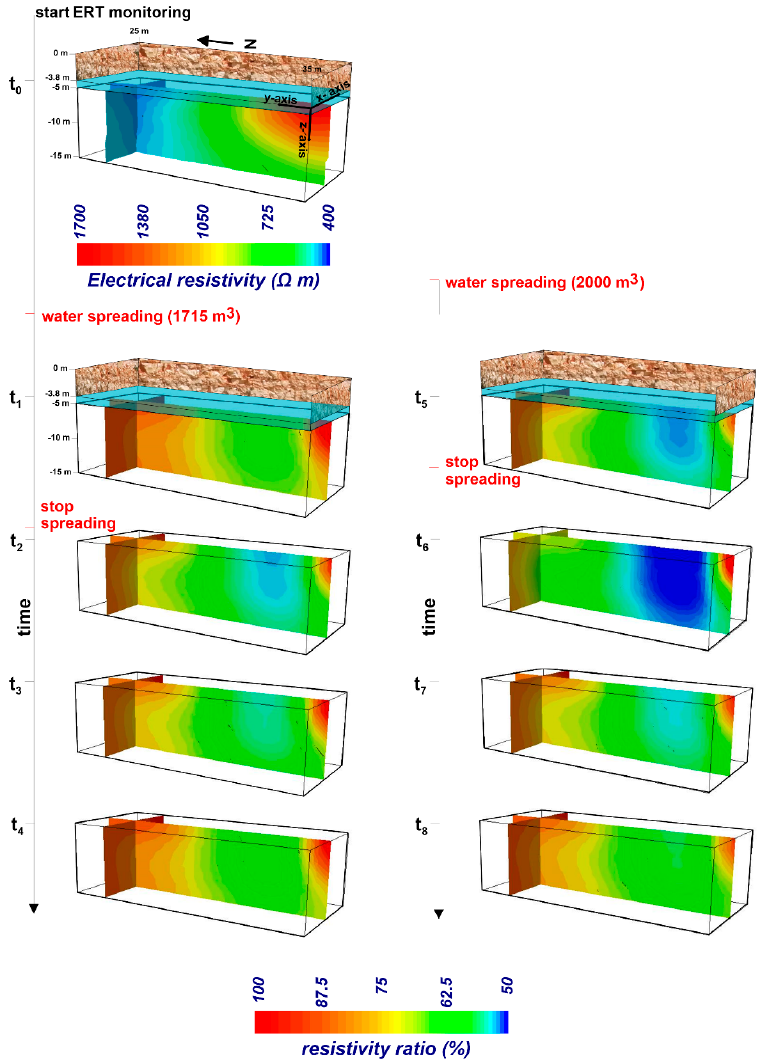
Figure 7. Resistivity ratio recorded for Trench 9 in March at eight time points during two spread cycles. The reference time was set to t 0 = 22 March at 12:30. Times t 1 and t 5 correspond to the first dataset collected after each spread (19 h and 11 h, respectively) while the filling of the trench was still going on.